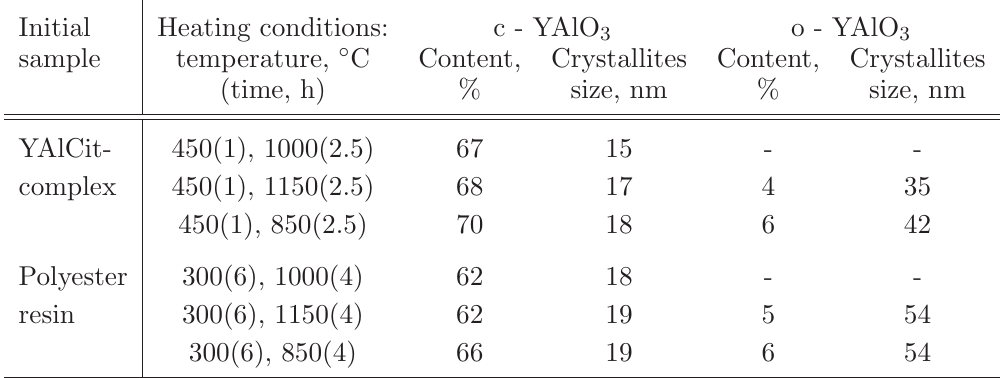
Table 4 Relative content of YAlO of YAlCit and the polyester